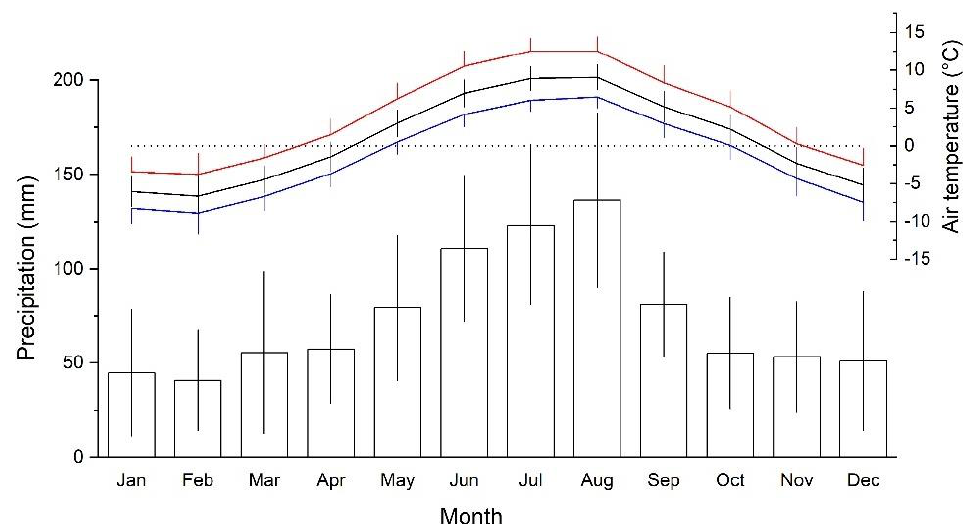
Figure 1. Mean monthly minimum (blue line), maximum (red line) and mean (black line) daily air temperature and mean monthly precipitation sums (bars) during the study period 1991 to 2020 at the meteorological station on top of Mt. Patscherkofel (2246 m asl). Standard deviations are indicated.